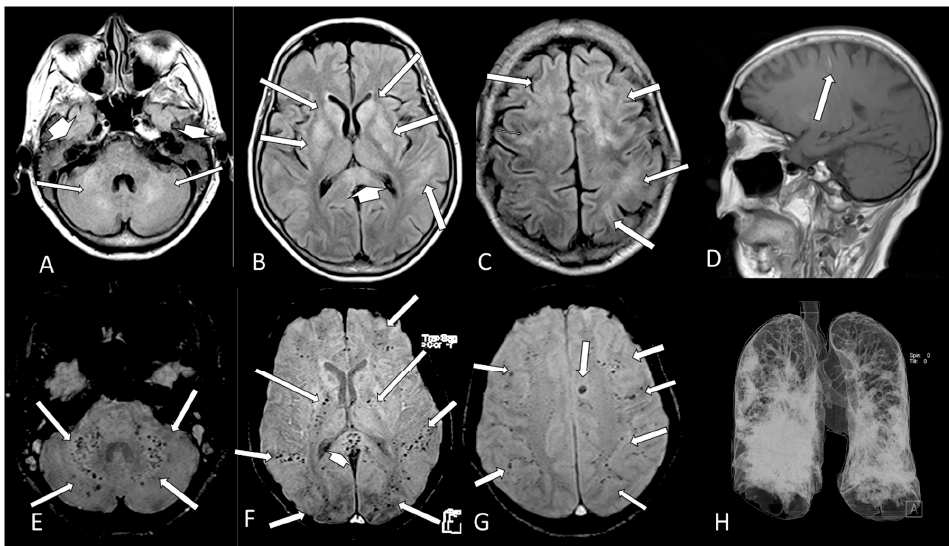
Figure 5. Case 30—The brain MRI shows multiple and confluent areas of diffuse hyperintensity on FLAIR ( A – C , arrows) and liquid in the mastoid cells ( A , short head of arrows). A small linear hyperintense subcortical on sagittal T1 ( D , arrow), which represents methemoglobin, is observed. There are multiple small dots of micro bleeds at the cerebellum and middle cerebellar peduncle ( E , arrows), intern capsule ( F , long arrows), splenium of corpus callosum ( F , head of arrow) and subcortical white matter ( F , G , arrows) of the brain. The 3D chest CT reconstruction shows that there is more than 50% of opacification in both lungs ( H ). Viruses 2021 , 13 , x